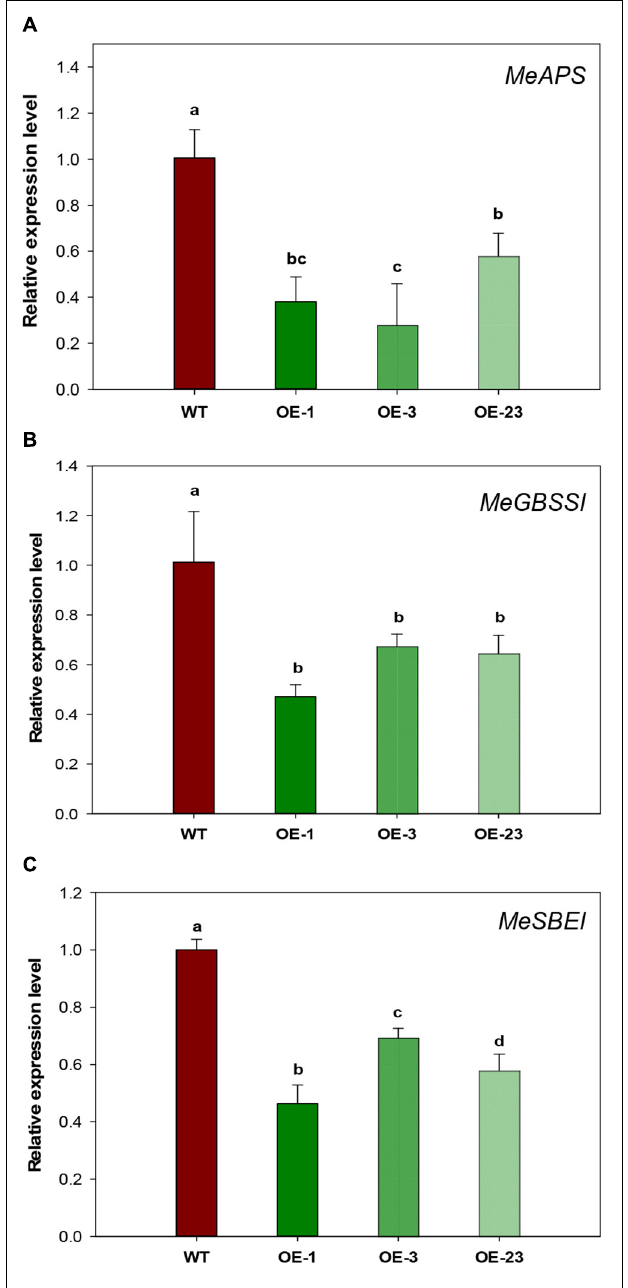
FIGURE 8 | Relative transcription levels of starch biosynthetic genes in storage roots of wild-type (WT) and the MeCWINV3 -overexpressed (OE) cassava plants. (A) MeAPS , the small subunit ADP-glucose pyrophosphorylase gene. (B) MeGBSSI , the granule-bound starch synthase I gene (C) MeSBEI , the starch branching enzyme I gene. Different letters indicate significant differences (one-way ANOVA, p <